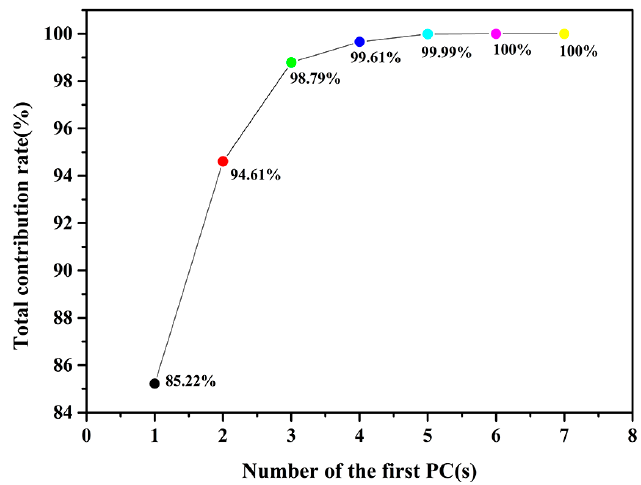
Figure 4. Contribution rate distribution of principal components (PCs).